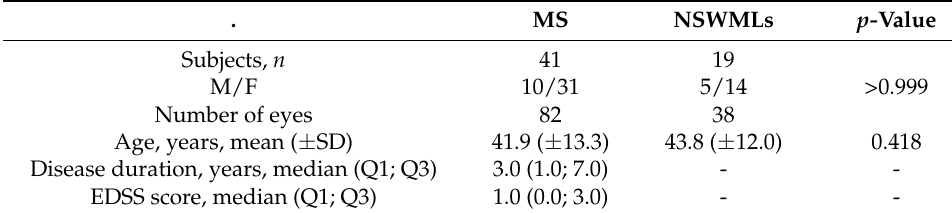
Table 1. Clinical characteristic of MS and NSWMLs